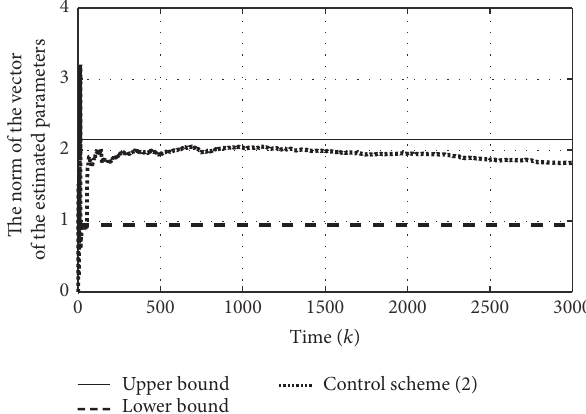
Figure18:Evolutioncurveofthenormofthevectoroftheestimated ̂ 𝜃(𝑘)‖ parameters ‖ .